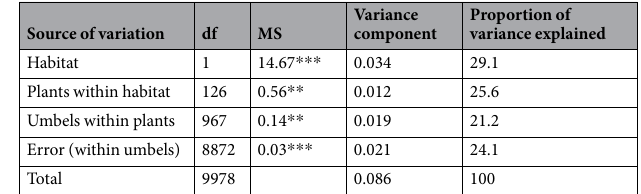
Variance component